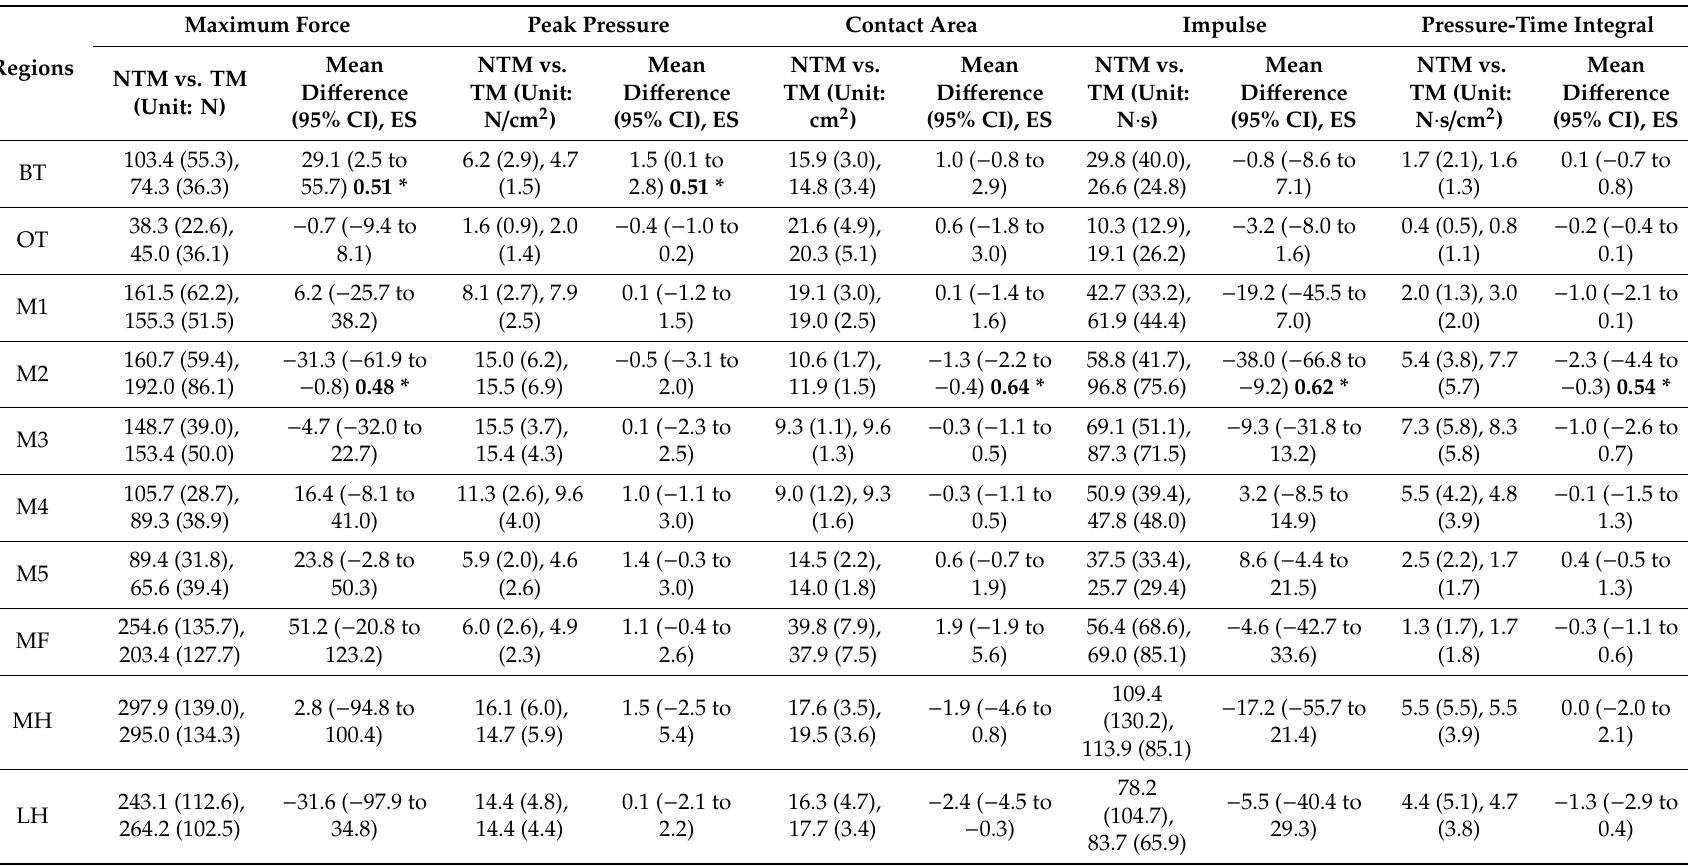
Table 2. The plantar pressure during landing in Non-Toe-Manipulation ( NTM ) and Toe-Manipulation ( TM ) sessions, including mean (SD), mean di ff erence, 95% confidence intervals and e ff ect sizes (ES) (Cohen’s d). * indicates significance with p < 0.05.